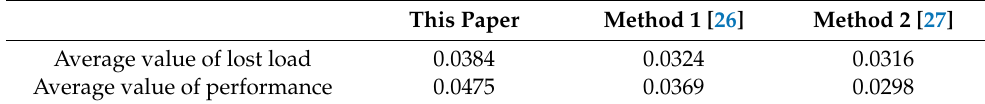
Table 5. Comparison of the average values of the two